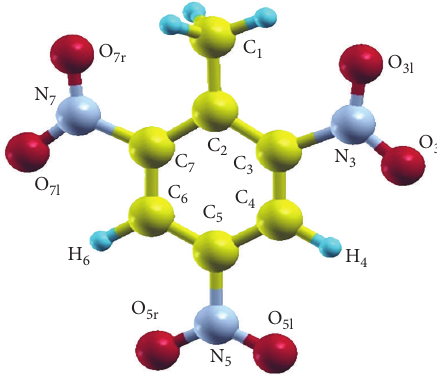
F 1: DFT-optimized TNT molecular